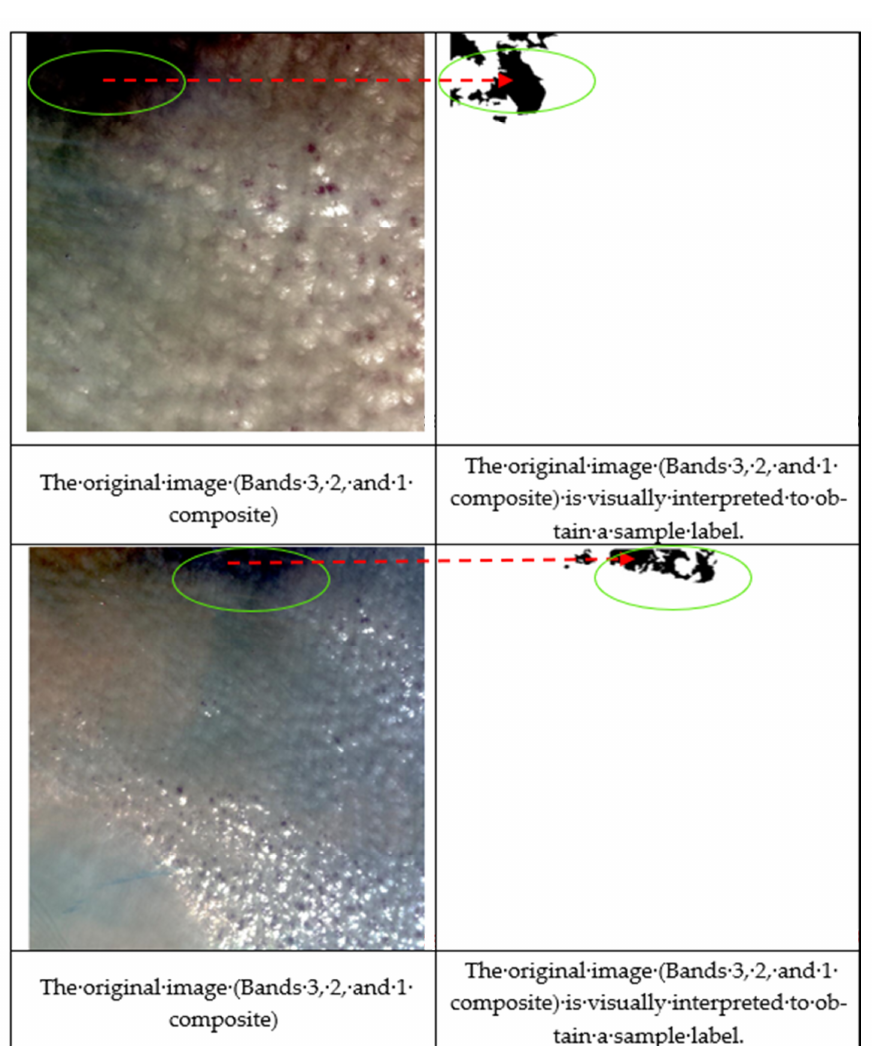
Figure 3. The comparison between the original images (Bands 3, 2, and 1 composite) and sample labels obtained by manual vectorization with the help of visual interpretation. Visual interpretation will vectorize the original images into clouds (white) and fog_W (black). The black circled in green is the fog_W recognized by visual